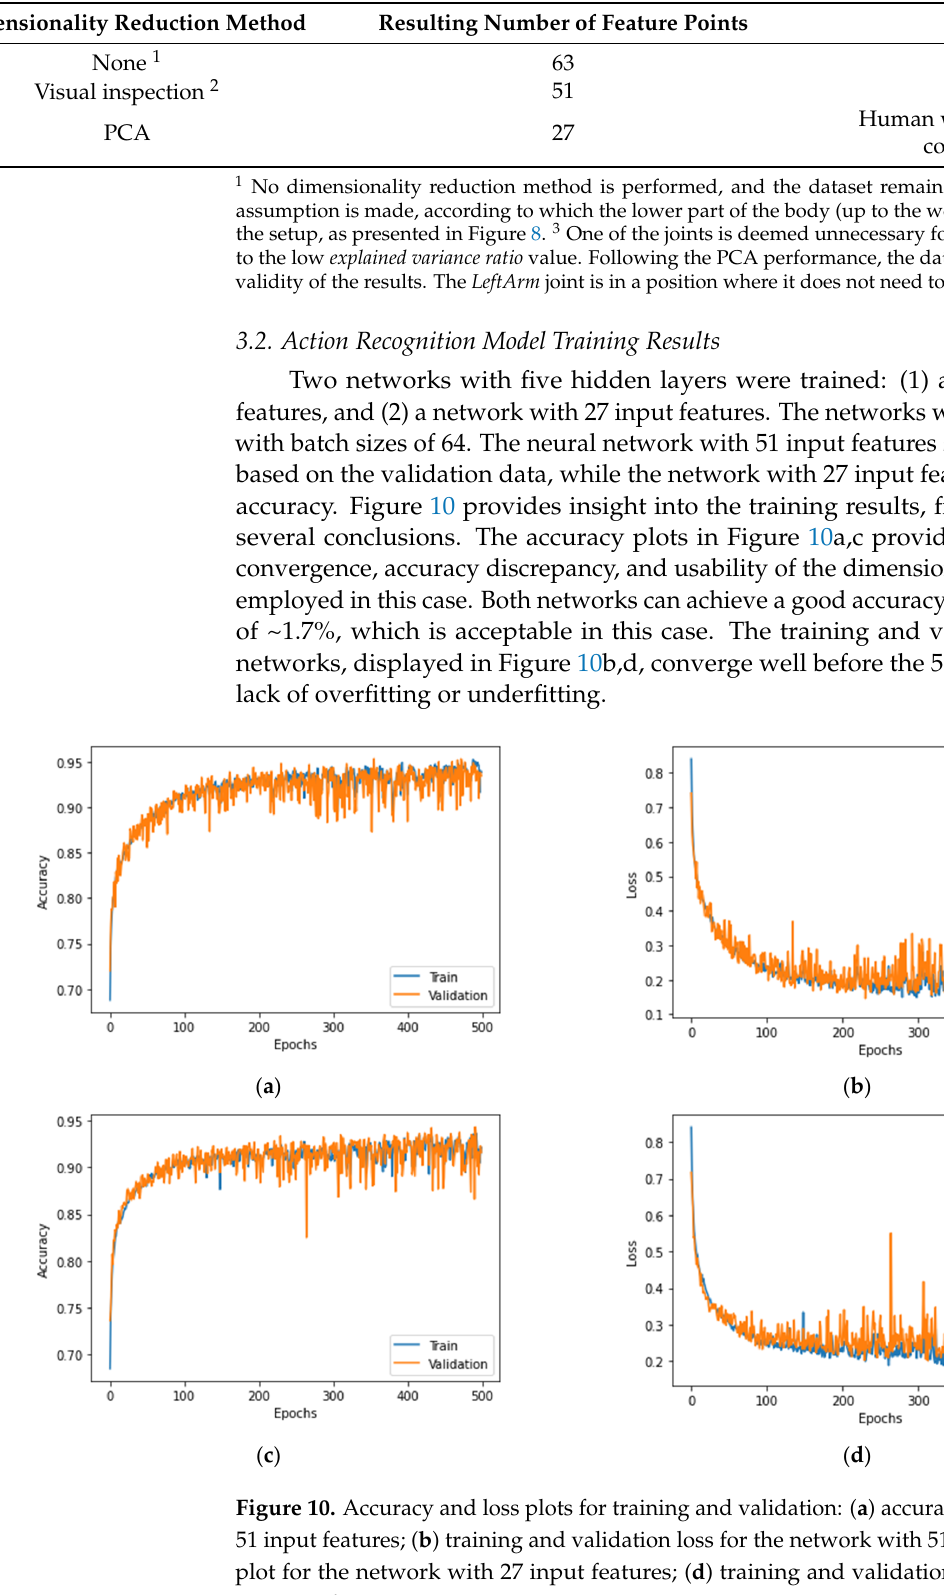
Table 2. Overview of the dimensionality reduction results.